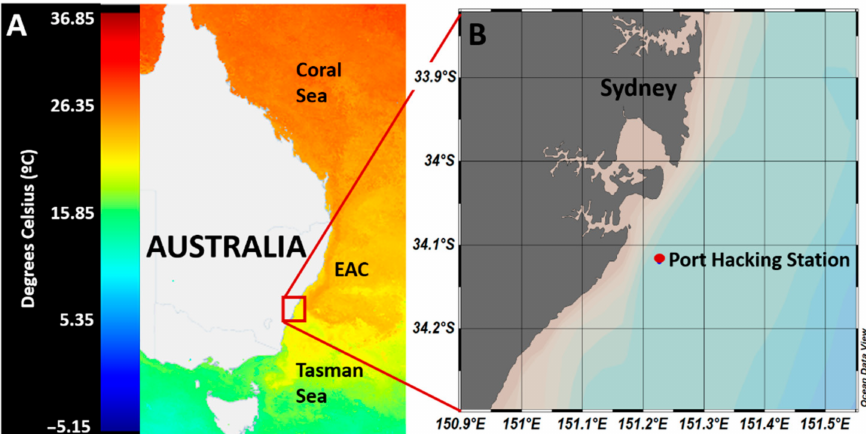
Figure 1. Location of the sampling site. ( A ) Satellite image of the sea surface temperature of the east coast of Australia on 14 April 2019 showing the location of Sydney basin and the position of the EAC relative to the Tasman and Coral Seas (modified from IMOS [38]). ( B ) Magnified inset image showing the location of Port Hacking station. Generated with Ocean Data View software